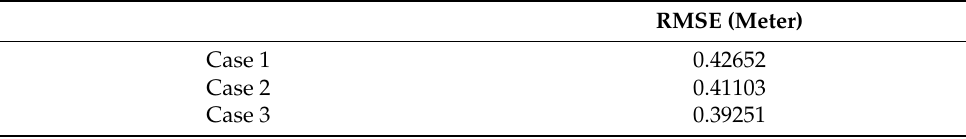
Table 9. Actual target measurement